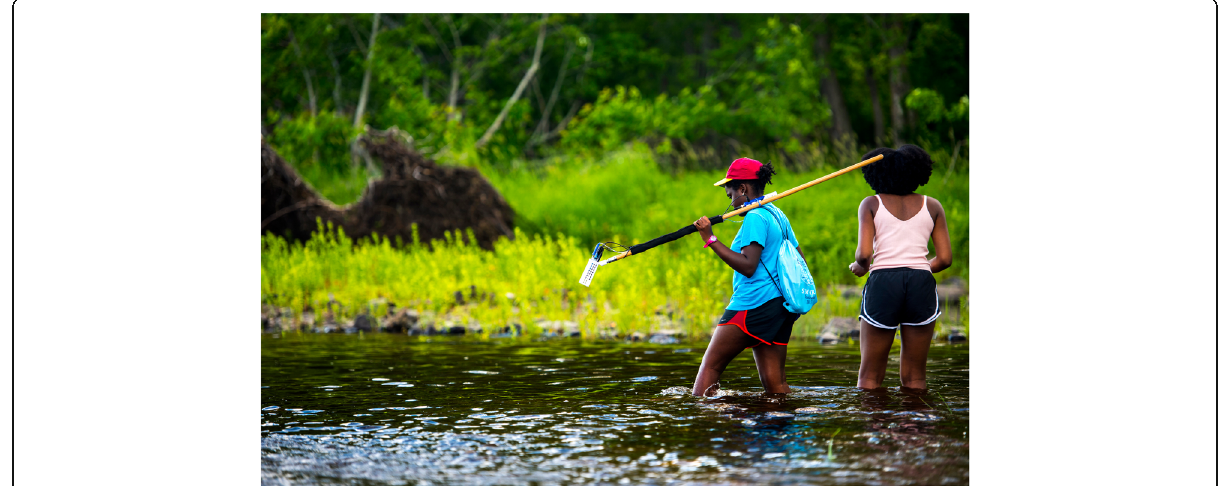
Fig. 1 SMART student using a data logger on a tributary of the Penobscot River, Orono,